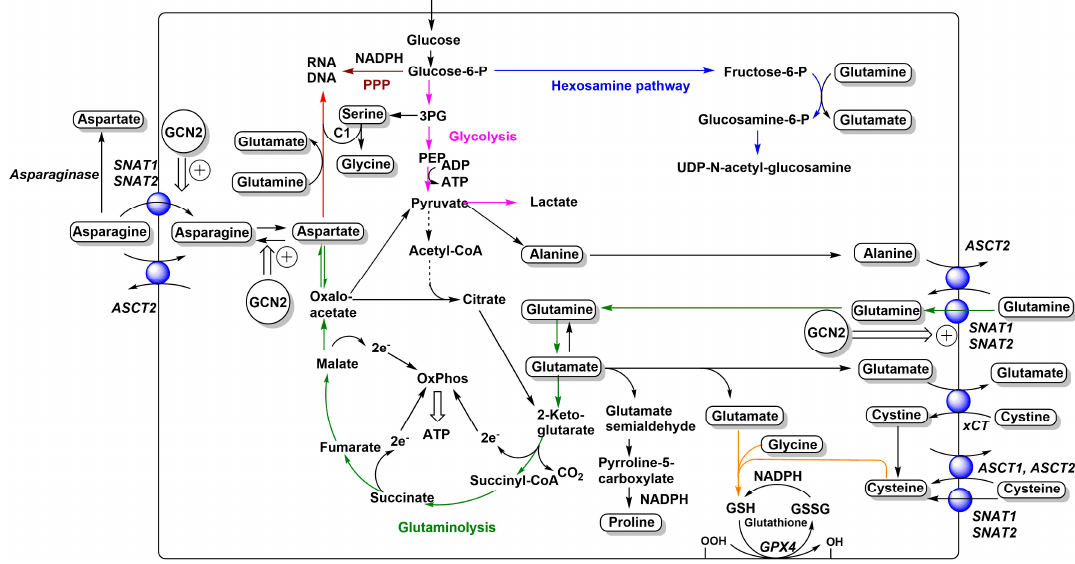
Figure 1. Relationships between neutral and anionic amino acid transporters and metabolism. The main amino acid-related metabolic fluxes in cancer cells, such as glycolysis (pink), glutaminolysis (green), nucleobase biosynthesis (red), hexosamine pathway (blue), glutathione biosynthesis (orange), and pentose–phosphate pathway (brown), are shown. Amino acids are depicted in rounded frames. Transporters that feed into these pathways are depicted as blue spheres and their names are shown in italics. Adaptive changes caused by GCN2 activation are shown as double arrows. Reduced flux of carbon from pyruvate to acetyl-CoA is indicated by a dashed arrow. For more detailed depictions of transport mechanisms, see Figure 2.